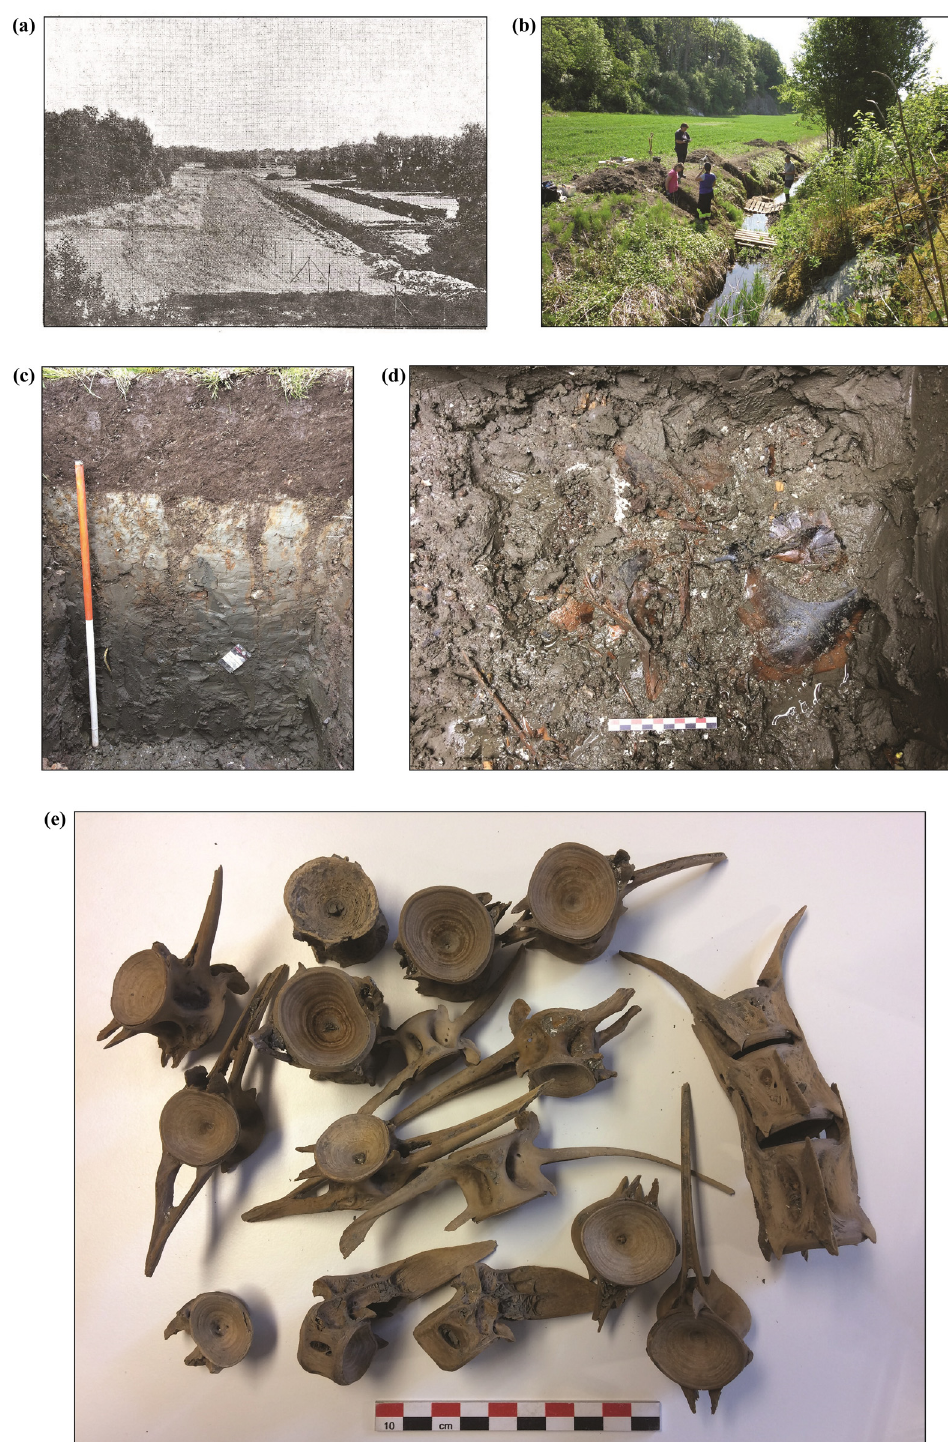
Figure 3: ( a ) A photo from 1931 of the ditch at Jortveit within which artefacts and fi sh bones fi rst appeared ( from Bakke, 1933, p. 36, Figure 1 ) . ( b ) Investigating the drainage ditch in 2018. ( c ) A soil pro fi le in trench 6 with the “ bone layer ” uncovered at c. 132 cm depth in the bottom of the trench. ( d ) The “ bone layer ” in trench 6 exposed with visible Blue fi n tuna bones. ( e ) A selection of Blue fi n tuna vertebrae from di ff erent trenches at Jortveit. Photos by Svein V. Nielsen, except ( a )